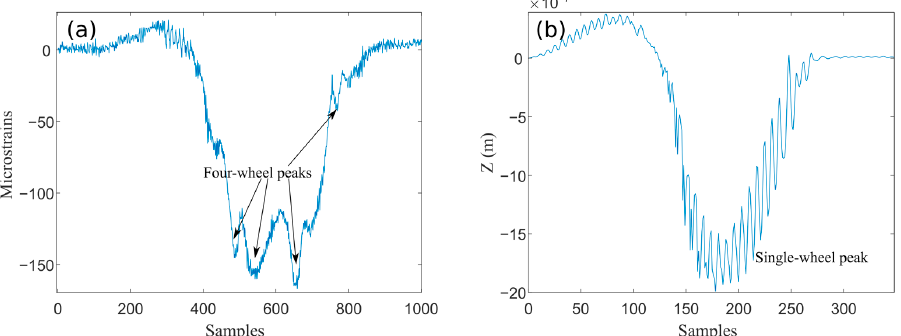
Figure 13. ( a ) A real measurement captured by a strain gauge sensor installed in a rail, ( b ) Time response of a single node of the proposed FEM model. The number of samples of both signals is different due to differences in the speed of the wheels and sample frequency rate.